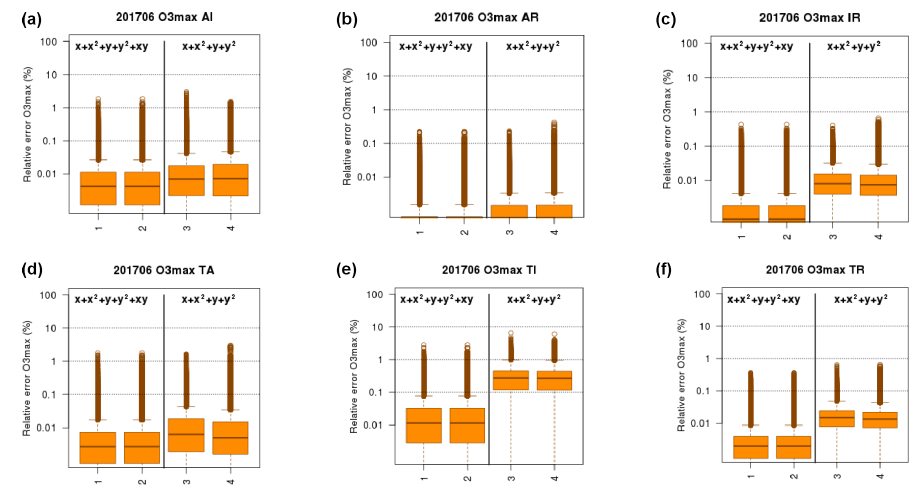
Figure 8. Same as Fig. 7 for O 3